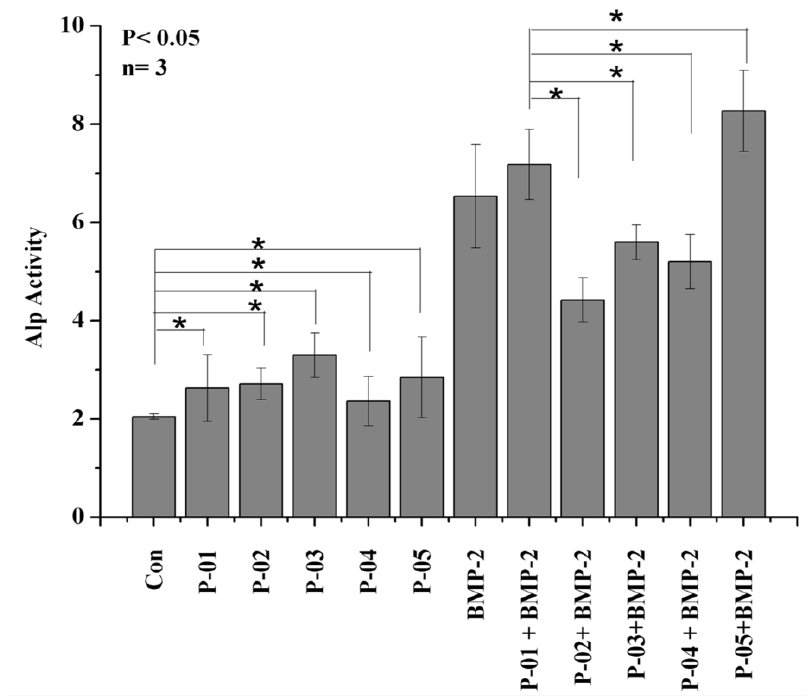
Figure 5. ALP activity in C2C12 cells (3 × 10 4 cells/well) cultured for six days in 24-well plates with peptides alone at a concentration of 500 nM, as well as in combination with the BMP-2 protein (2.5 nM) and peptides at a concentration of 500 nM. The control group for the combination of the protein and peptides included peptide P-01 and the BMP-2 protein. * p < 0.05 compared to the control group ( n =